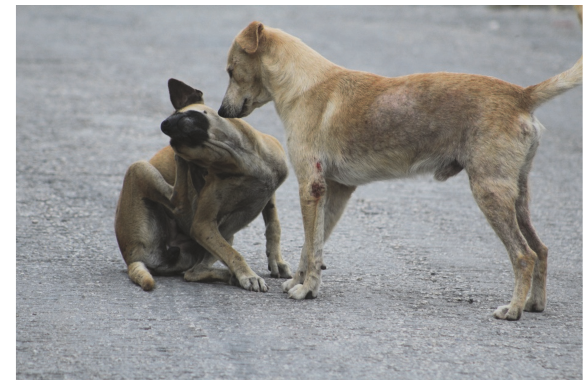
Figure 2: A typical “malix” free roaming male dog from San Francisco de Campeche.